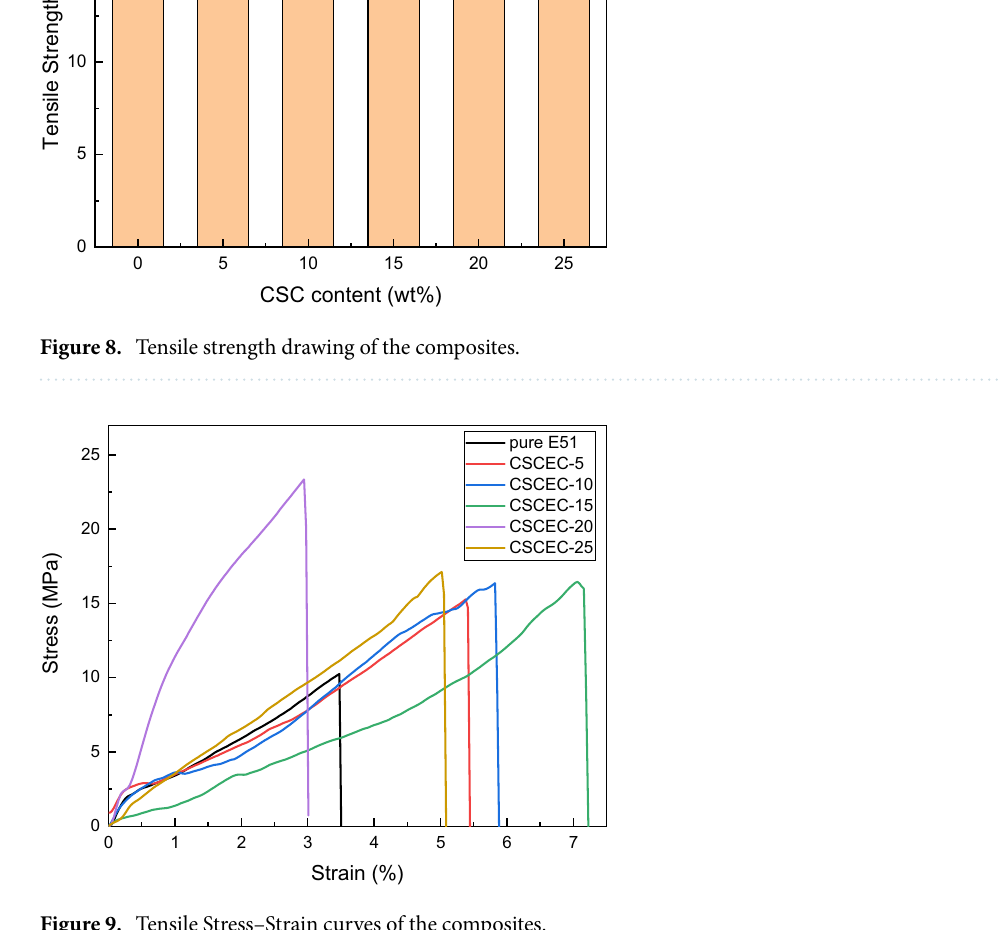
Figure 9. Tensile Stress–Strain curves of the